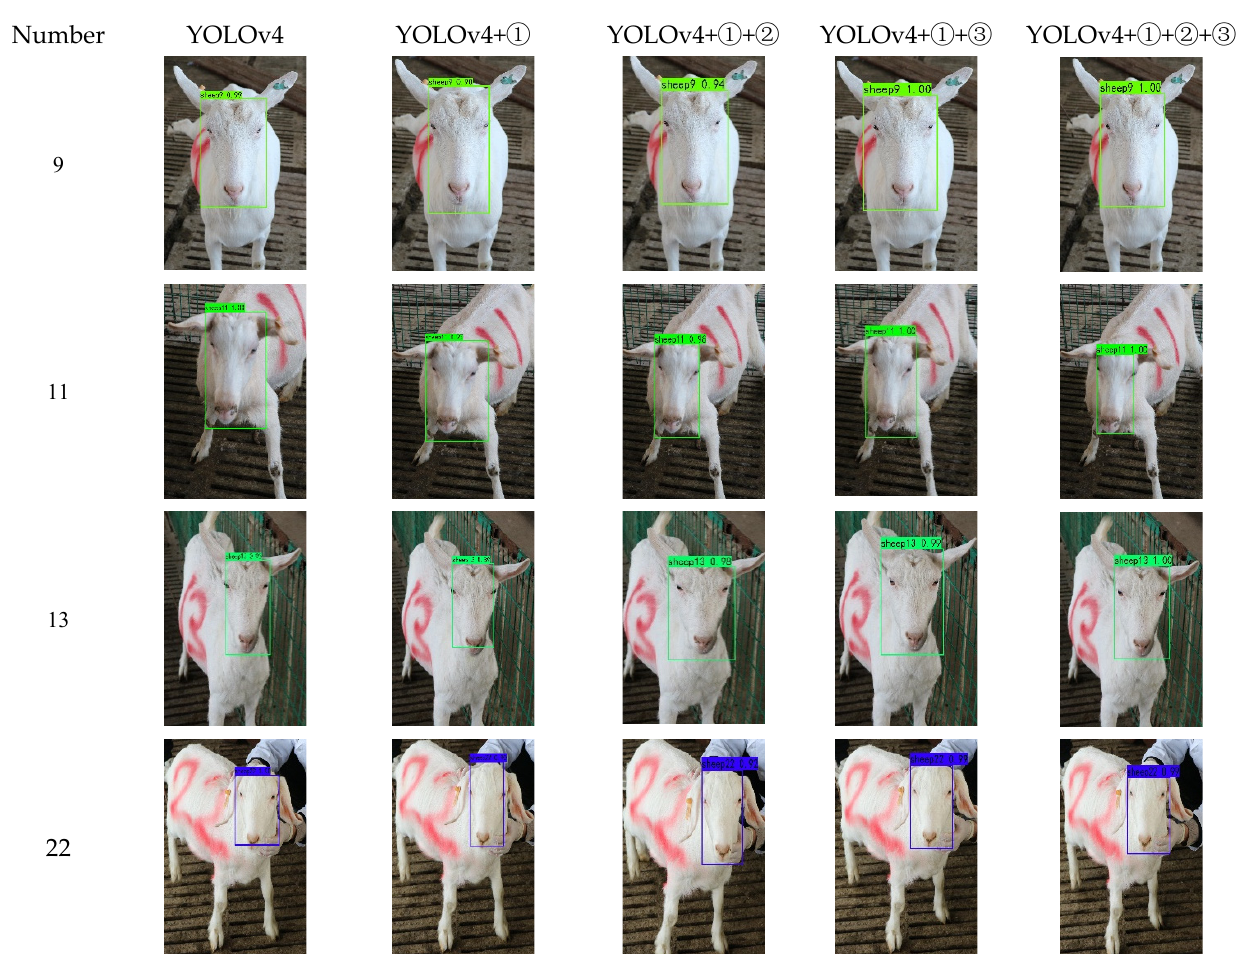
Figure 7. Different models of face-recognition results (IOU = 0.5).